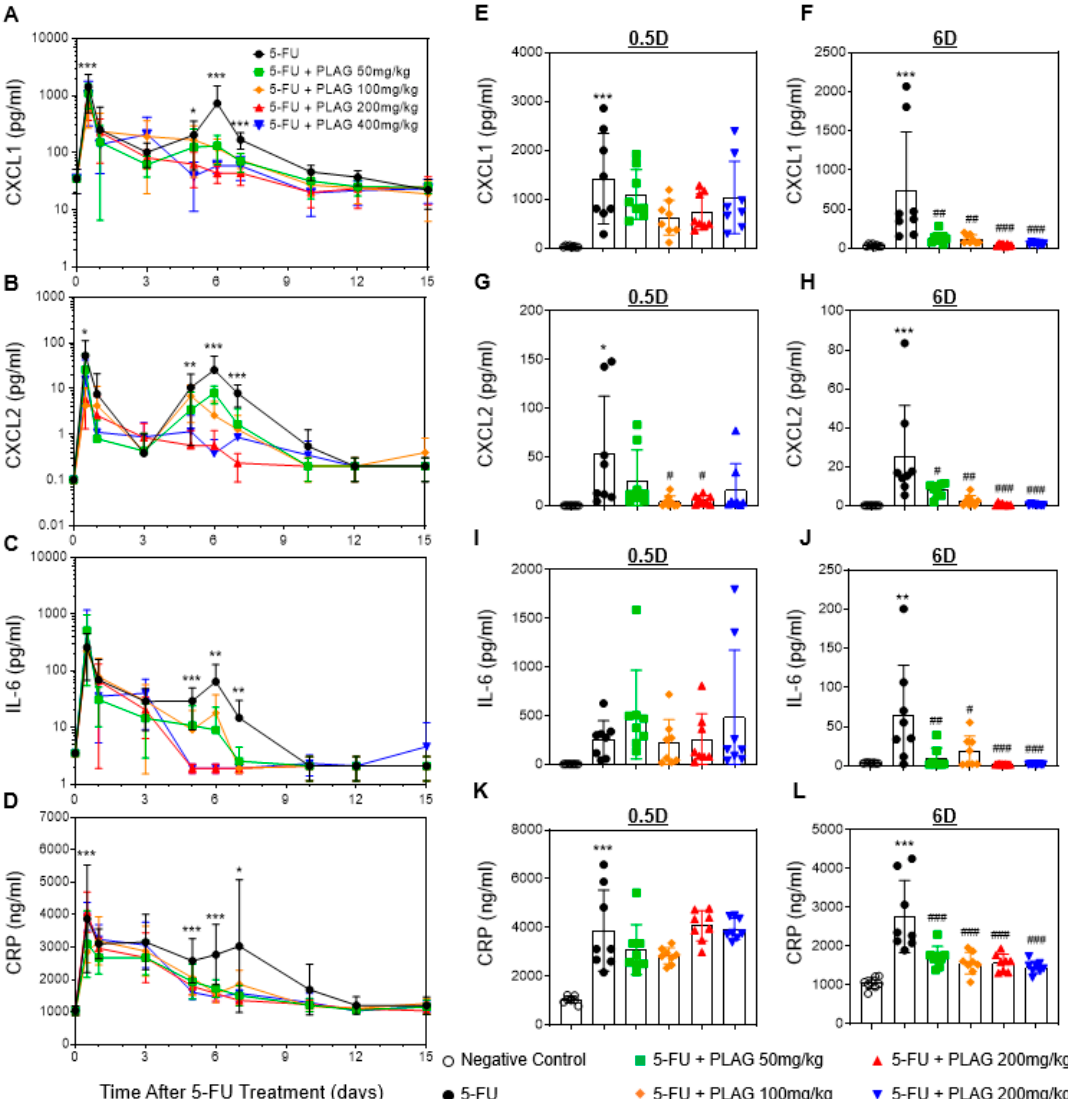
Figure 5. PLAG attenuates blood levels of 5-FU-induced pro-inflammatory cytokine / chemokines and C-reactive protein (CRP). Mice ( n = 8 males per group) were intraperitoneally injected to 100 mg / kg of 5-FU immediately followed by oral administration of 50, 100, 200, and 400 mg / kg of PLAG, continuing daily until day 15. E ff ect of PLAG administration on the kinetics of ( A ) the chemokine (C–X–C motif) ligand 1 (CXCL1), ( B ) CXCL2, ( C ) interleukin-6 (IL-6), and ( D ) CRP in blood after 5-FU injection. Individual data of CXCL1, CXCL2, IL-6, and CRP on 0.5 day ( E , G , I , K ) and six days ( F , H , J , L ) after 5-FU injection are presented as dots. The luminex and ELISA data are representative of five independent experiments with eight mice per group. * indicates negative control vs. 5-FU and # indicates 5-FU vs. 5-FU + PLAG-treated groups. * / # p < 0.05, ** / ## p < 0.01, *** / ### p < 0.001. ns., not significant.